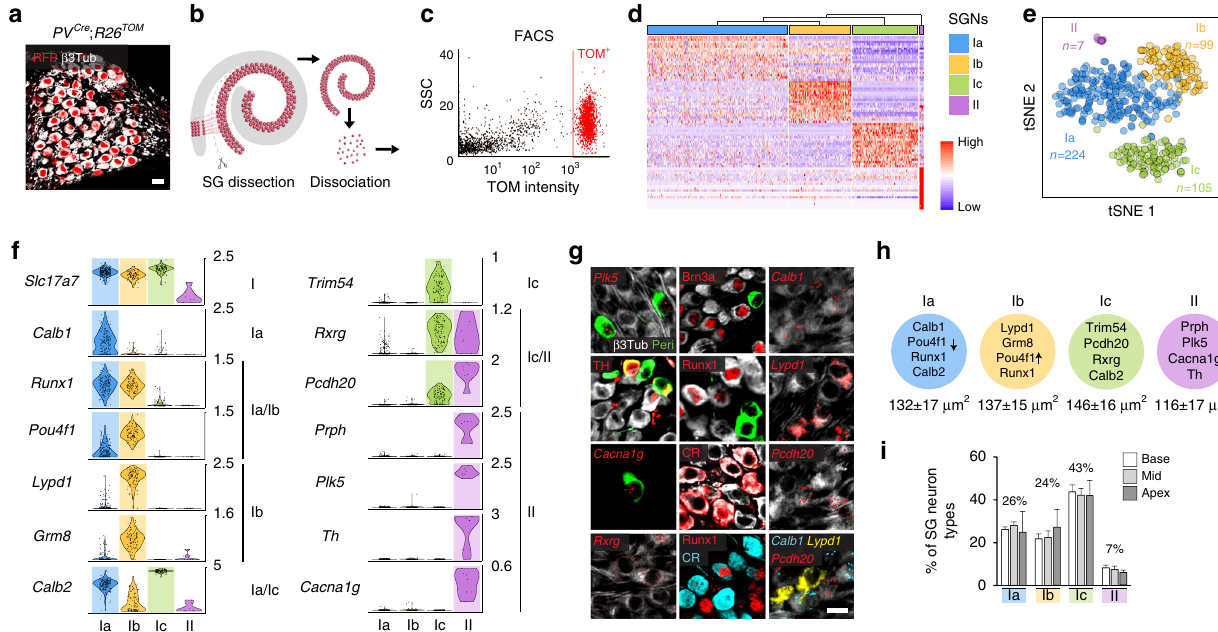
Fig. 1 Identi fi cation and validation of four neuronal types in adult SG. a Genetic tracing of SG neurons ( β 3Tub + /RFP + ) on P21 sections from PV cre ; R26 TOM mice. b Sketch depicting dissection of SG from the organ of Corti and their dissociation. c Fluorescence-side scatter plot of dissociated single cells showing isolation of Tom + SG neurons through FAC sorting. d Heat map showing single-cell expression of the top 20 differentially expressed genes in the four types of SG neurons, from combined data of P17, P21, and P33 neurons (SGNs, SG neurons). Dendritic tree shows the similarity between neuronal types. e tSNE plot showing four distinct types of SG neurons. f Violin plots showing the expression of marker genes in log-transformed scale among the four different populations of SG neurons. g In vivo validation of the identi fi ed SG neuron types by immunohistochemical and fl uorescent in situ hybridization using identi fi ed marker genes in P21 cochlea. Type II neurons were identi fi ed by peripherin (Peri), Plk5 , TH, and Cacna1g speci fi cally. Ia neurons were identi fi ed by Calb1 , Pou4f1 , Runx1, and calretinin (CR). Ib neurons were identi fi ed by Lypd1 , Runx1, and Pou4f1 and Ic neurons, by Rxrg , Pcdh20 , and CR expression. Note that co-localization on sections could never be observed for markers expressed in different populations of neurons in the scRNAseq data. h Schematic representation of neuronal types with their key markers and their average soma size (in µ m 2 ) at P21. i Proportion of SG neurons types along the tonotopic gradient (from base to apex) quanti fi ed by Runx1, Peri, and CR expression at P21 ( n = 3 animals; Data are represented as mean ± SEM).